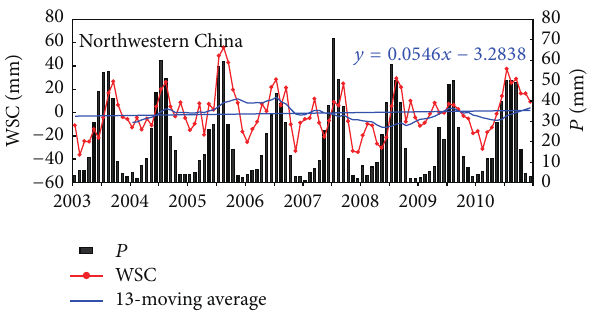
Figure 5: Time series of WSC and precipitation ( 𝑃 ) over northwest- ern China from 2003 to